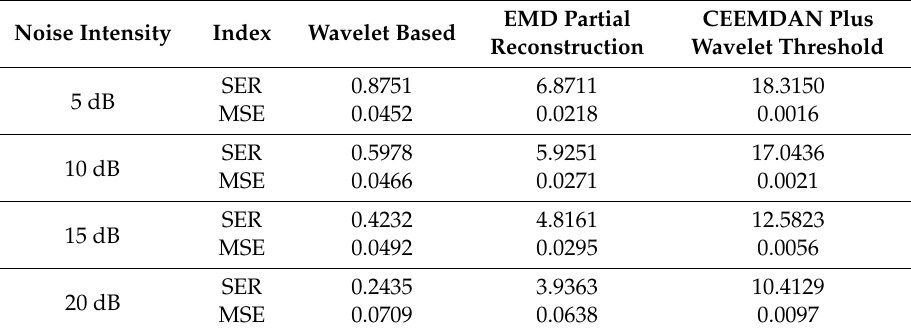
Table 2. Performance indices under different noise intensity (simulated ECG).